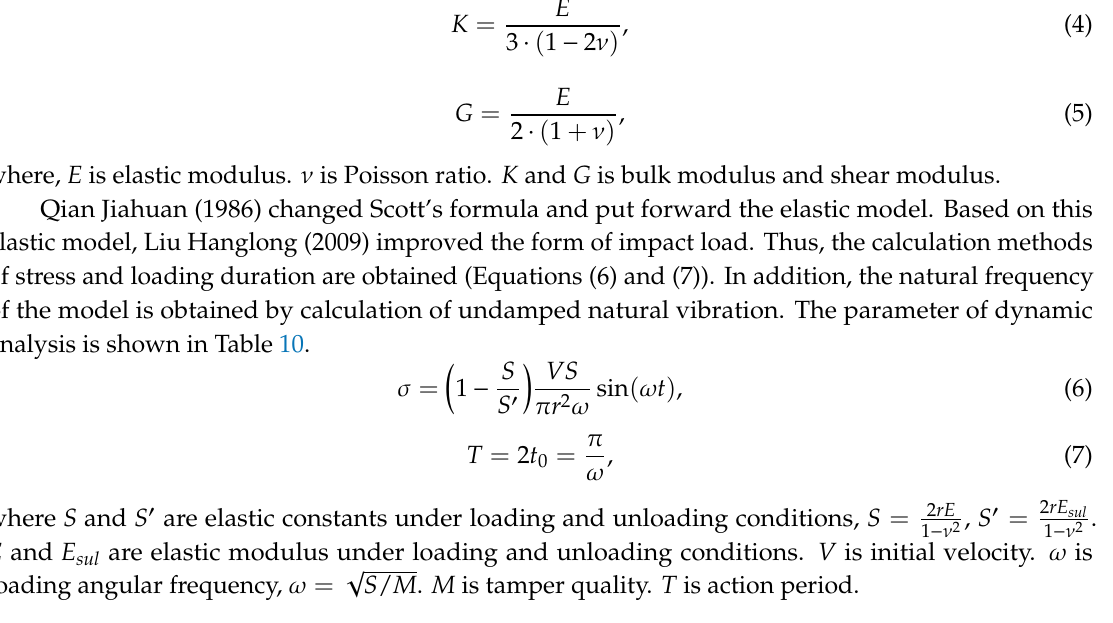
Table 8. Mechanical parameters of the soil